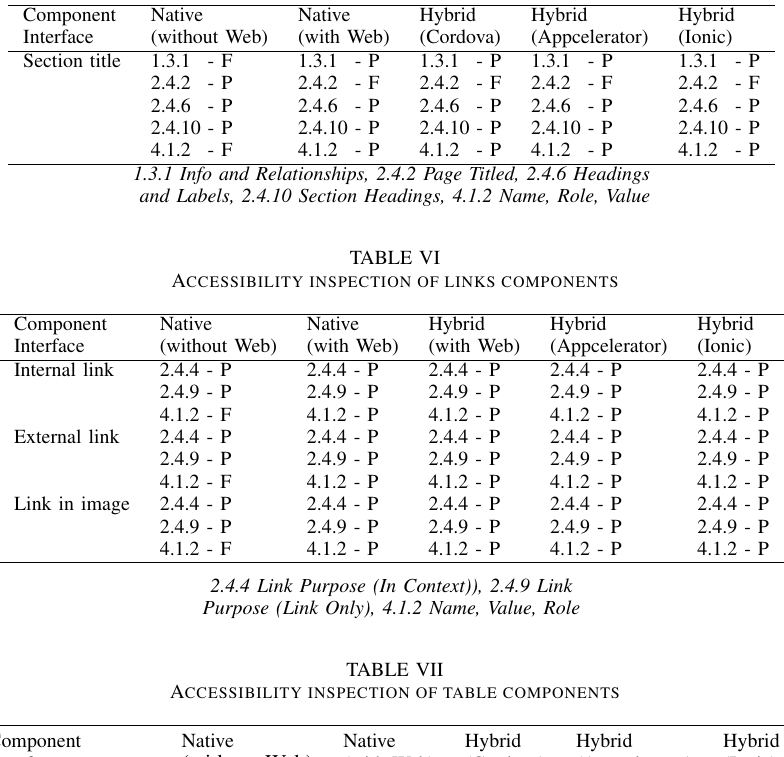
TABLE V A CCESSIBILITY INSPECTION OF HEADING COMPONENTS